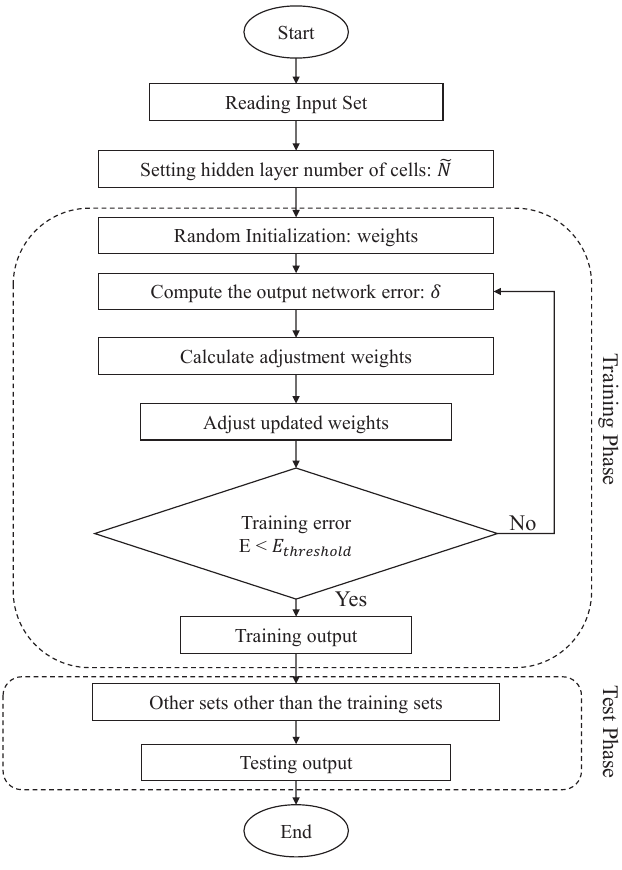
Figure 2. Back-Propagation Neural Network (BPNN) prediction model framework